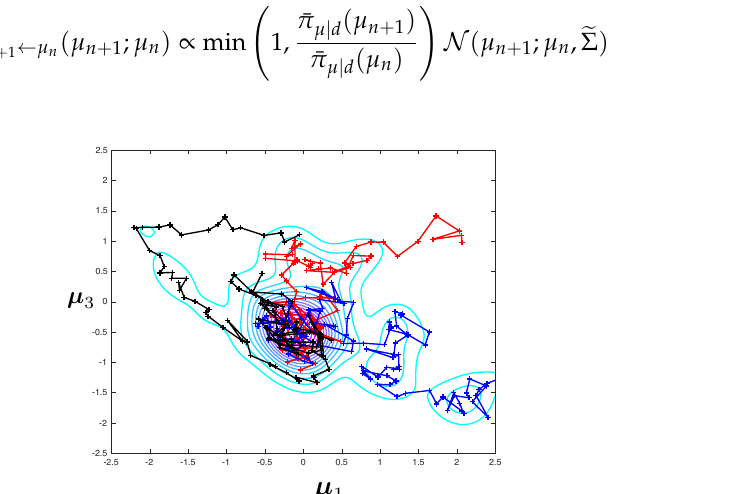
Figure 5. Three independent MCMC chains sampling a multivariate Gaussian